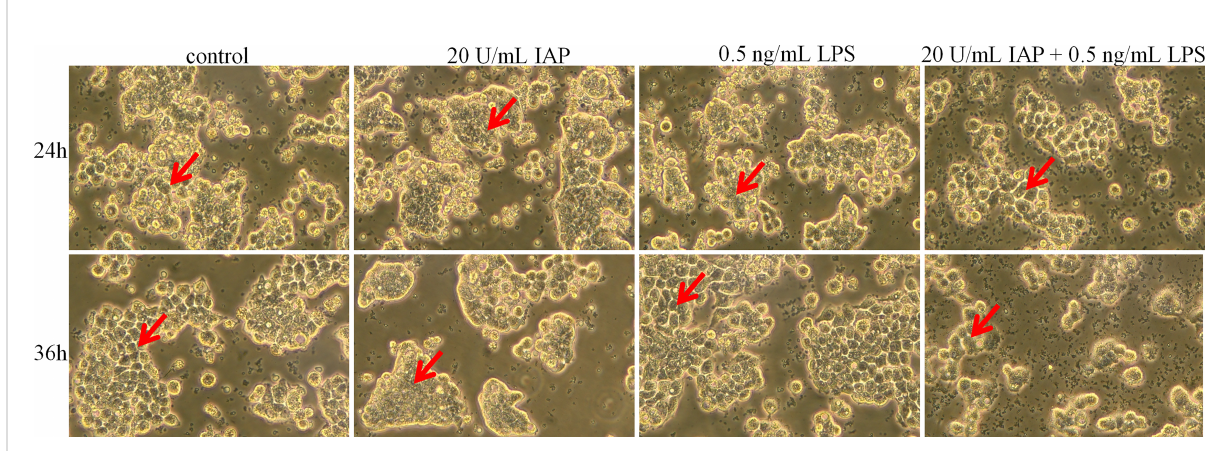
FIGURE 6 Effect of IAP on LPS-induced cell morphology in co-cultured HT-29 cells + freshly extracted human leucocytes. Cell morphology was obtained by taking bright fi eld images with an OLYMPUS inverted microscope (×100). All experiments were repeated at least thrice, and a representative fi gure is displayed. The arrows point to the observation areas of